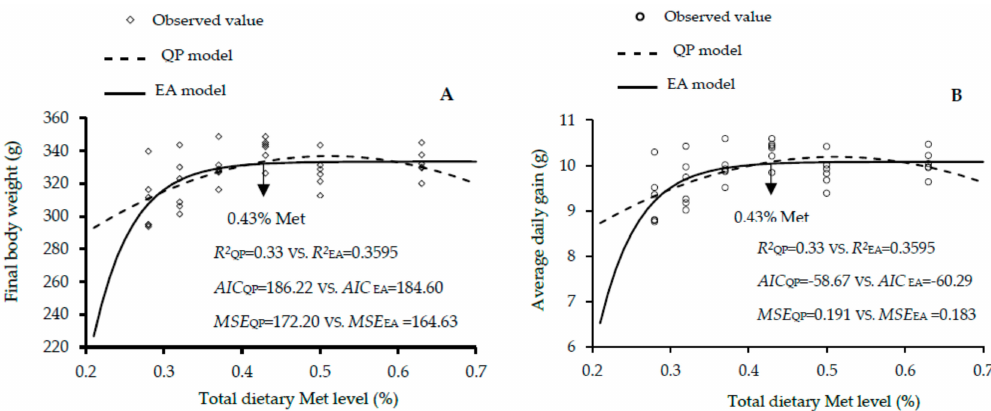
Figure 5. Regression models plot of growth performance as a function of total dietary Met level (0.28%, 0.32%, 0.37%, 0.43%, 0.50%, and 0.63% Met) of female slowly growing yellow-feathered chickens between 0 and 30 days of age. Correlation coe ffi cient ( R 2 ), Akaike information criteria (AIC) and mean squares error (MSE) are indicators used in evaluating fitness of models. ( A ) The optimum response arrow pointing at 0.43% Met by the best fitting model. ( B ) The optimum response arrow pointing at 0.43% Met identified by the best fitting regression model.